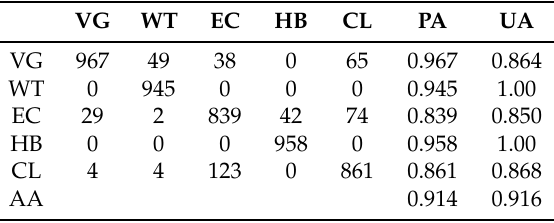
Table 7. Confusion matrix of the proposed method in the first area.